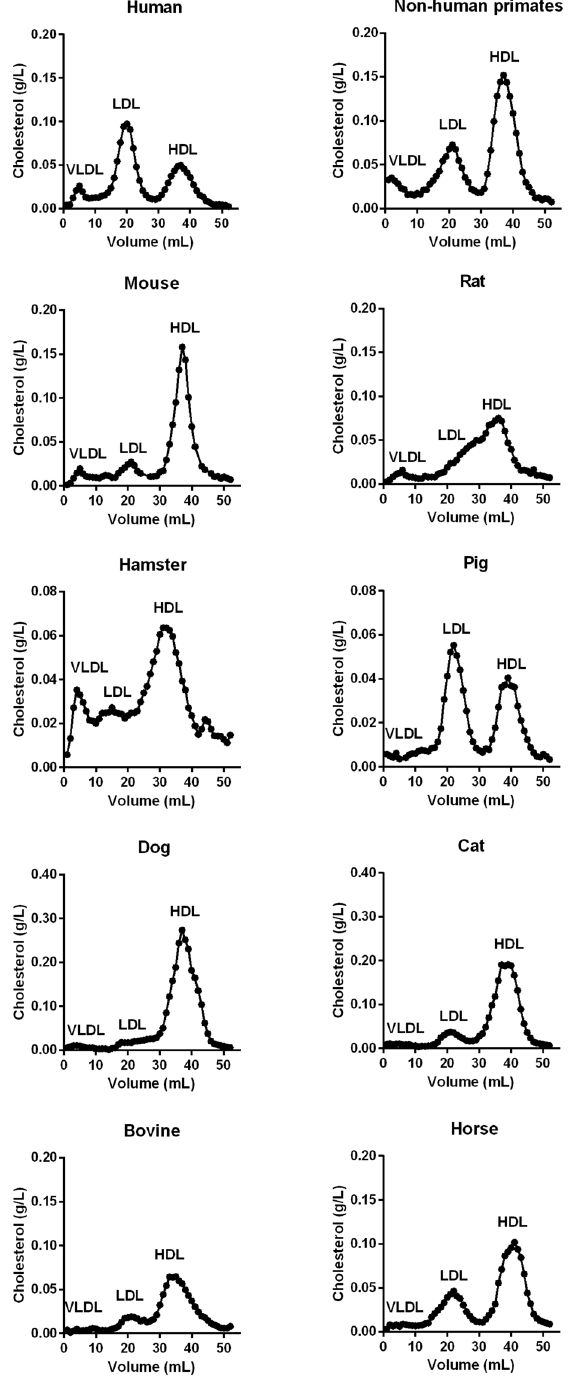
Figure 1. Lipoprotein profiles of studied species. The mean lipoprotein profiles (n = 6) were obtained by fast performance liquid chromatography